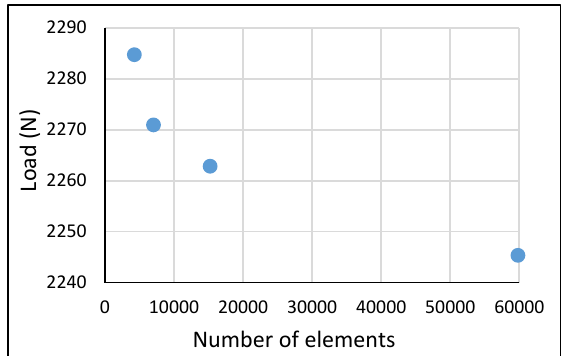
Figure 5. Mesh convergence results of the flexural specimen in the longitudinal direction.